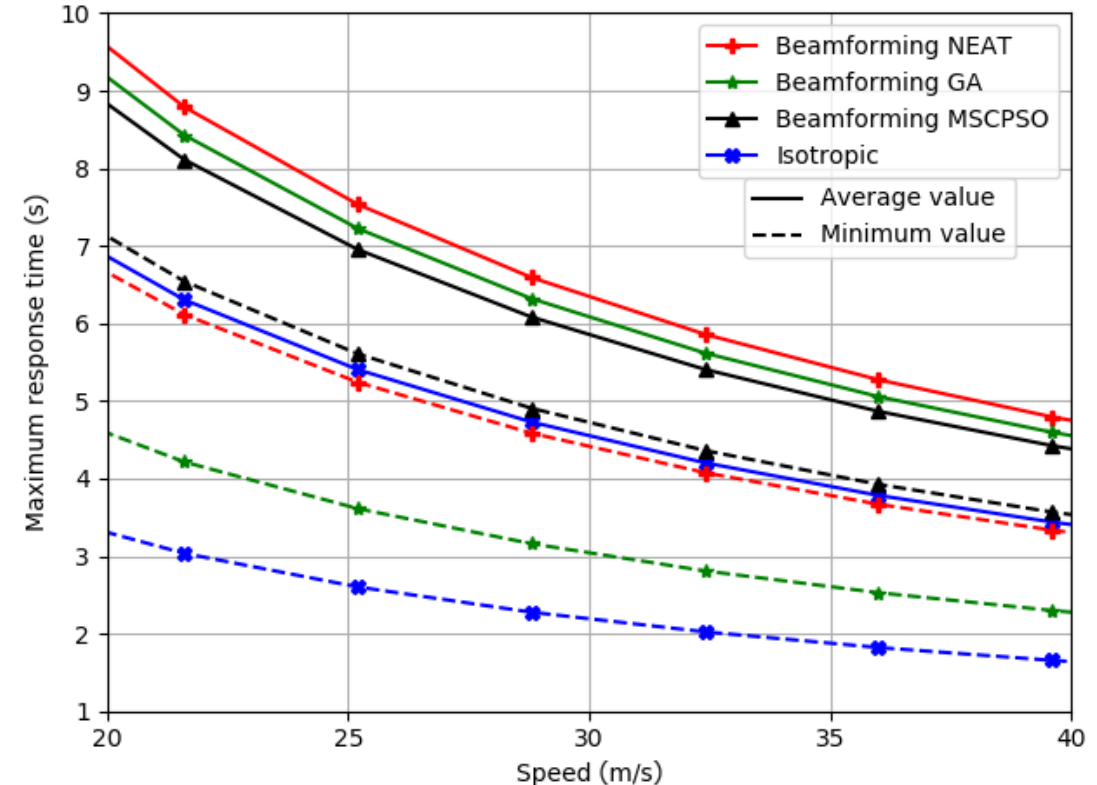
Figure 6. Maximum response time for the different evaluated